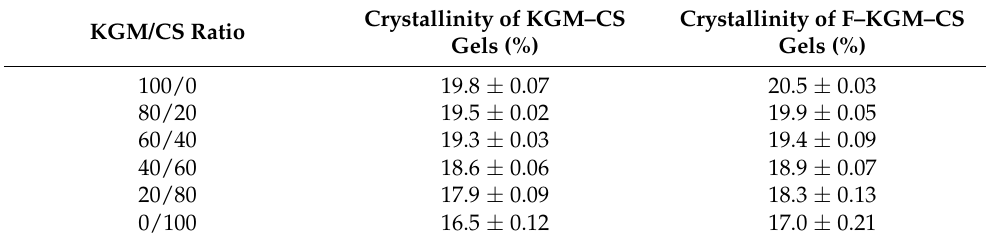
Table 1. The crystallinity of composite gels.